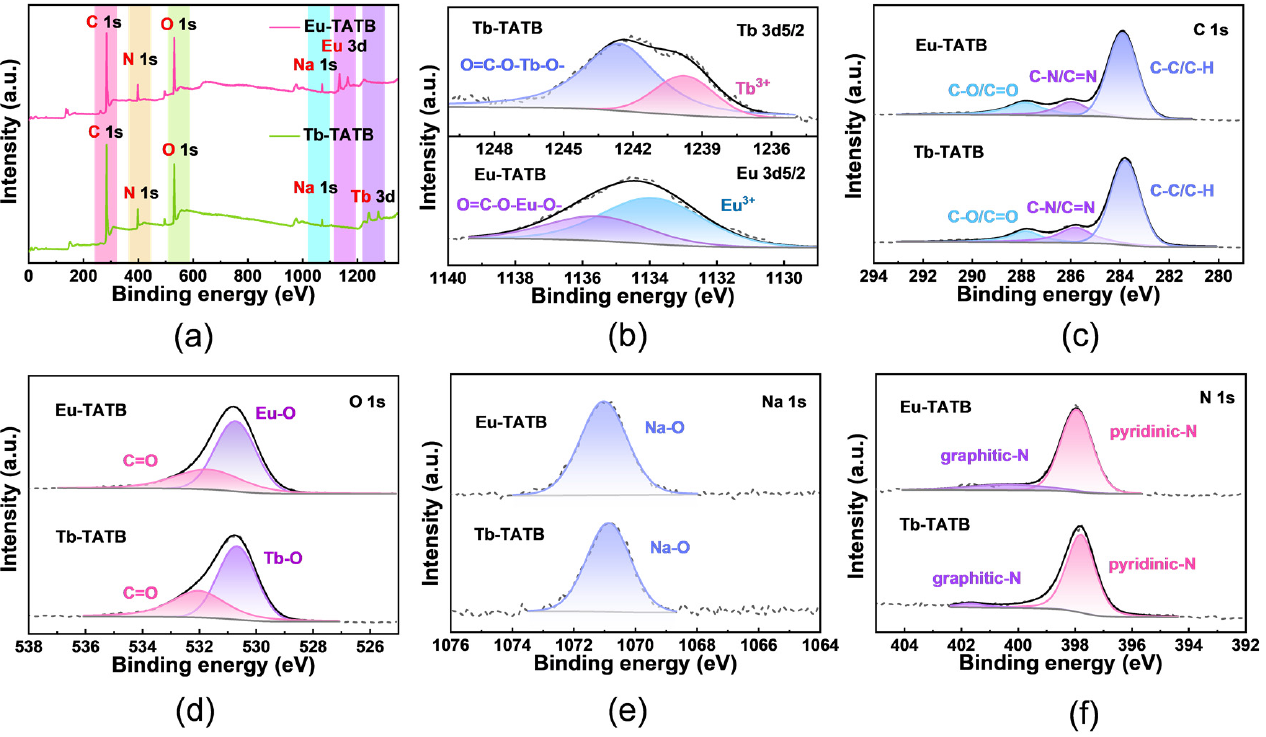
Figure 3. High-resolution XPS spectra of ( a ) survey scan, ( b )Tb 3d5/2 and Eu 3d5/2, ( c ) C 1s, ( d ) O 1s, ( e ) Na 1s, and ( f ) N 1s.